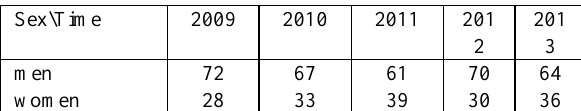
Table 4 . Percent of leptospirosis genders from 2009 to 2013